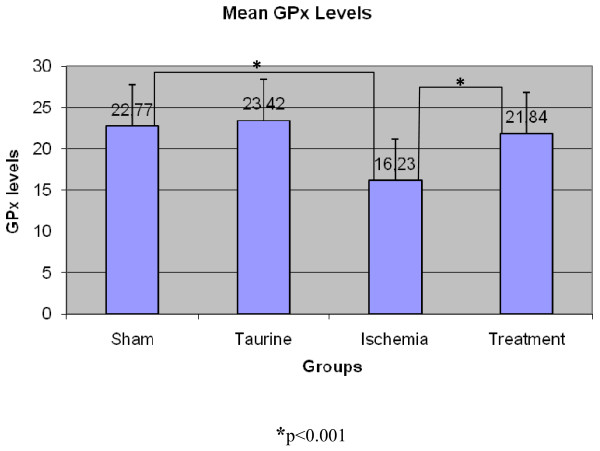
GPx enzyme levels in rat myocard tissue.